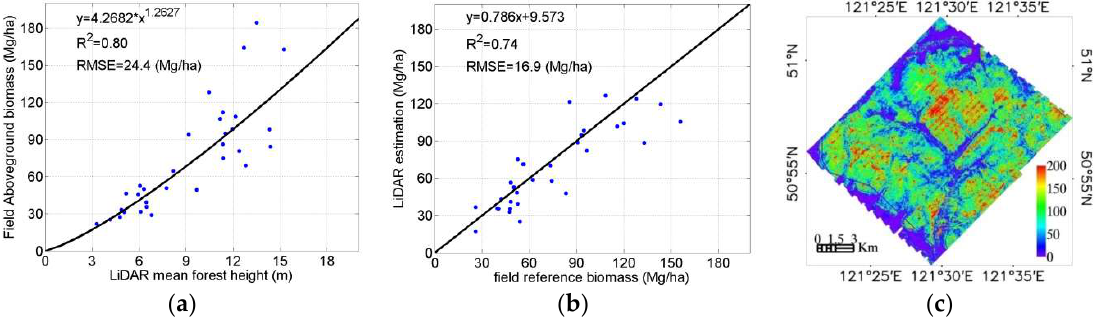
Figure 2. Generation of forest aboveground biomass (AGB) reference using Lidar data. ( a ) Model development (32 plots); ( b ) model validation (31 plots); ( c ) forest AGB map with a resolution of 15 m from lidar